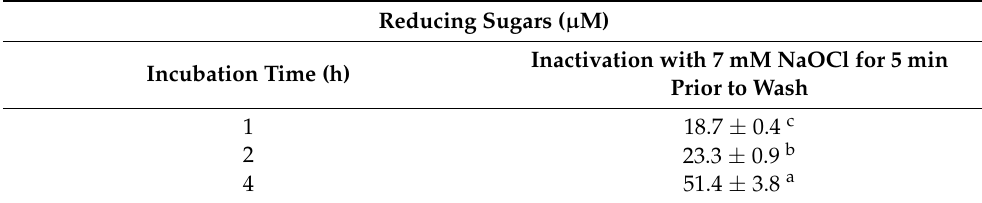
Table 5. Reducing sugar concentration of 15% raw potato starch treated with 1.2 mg mL − 1 (~190 nM) Bl - α Amy for 1–4 h and inactivated by 7 mM NaOCl for 5 min before the multistep washing procedure. Different superscript letters a–c indicate significantly different reducing sugar concentrations at p < 0.05 (one-way ANOVA, based on the Tukey–Kramer statistical comparison